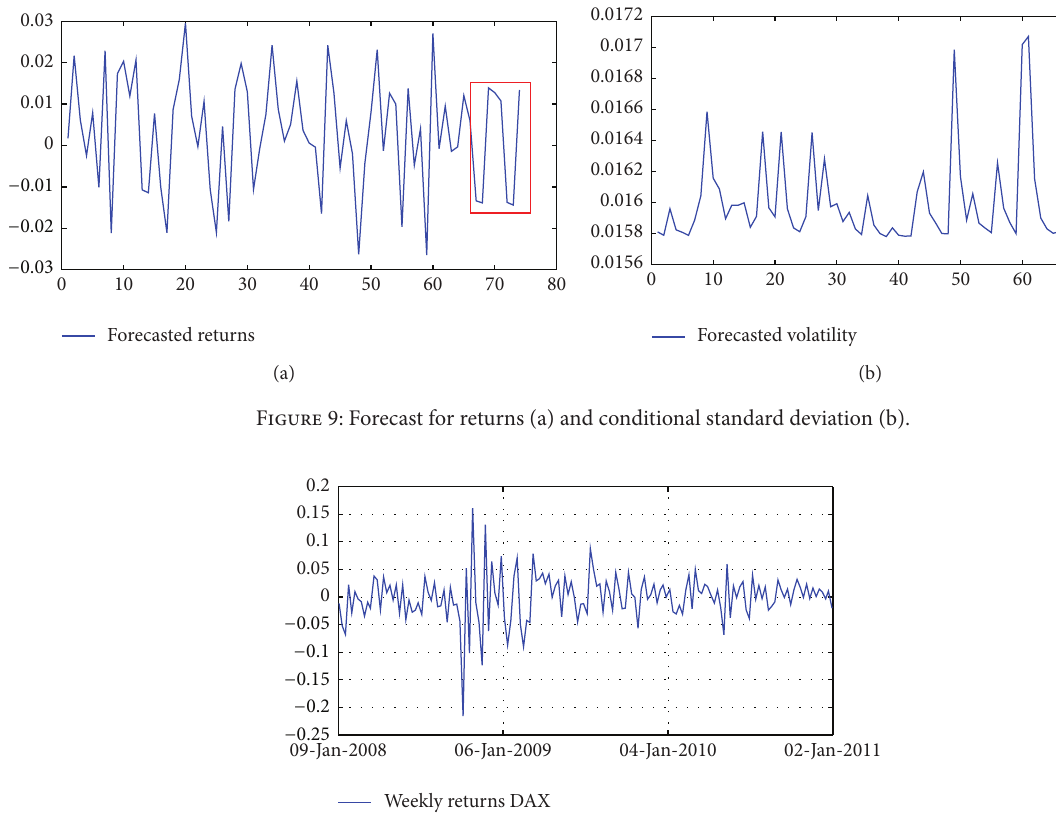
Figure 10: Weekly returns of DAX from 1st January 2008 to 1st January